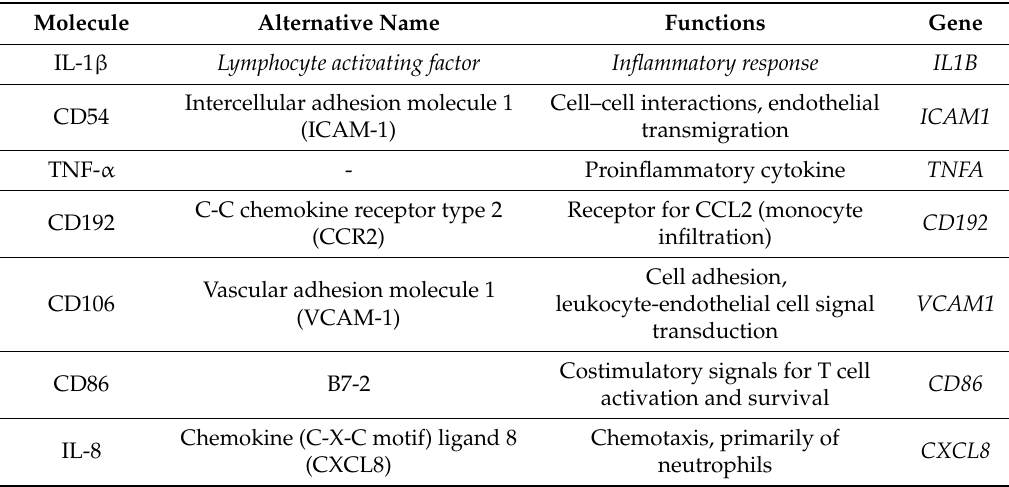
Table 4. ImmunologicallyrelevantmoleculesselectedbasedonmicroarrayanalysesinTHP-1macrophages exposed to NPs and their